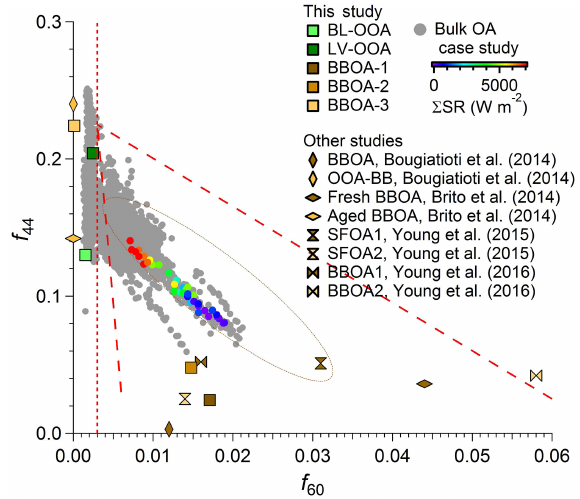
Figure 4. Scatterplot of f 44 vs. f 60 . The grey markers correspond to the measured OA during this study, and the SRCF case study data are colored by cumulative solar radiation ( P SR). In addi- tion, the five OA factors identified in this study are shown as solid squares, and the BBOA factors reported in the literature where mul- tiple BBOA factors were derived are shown with different markers. The dashed red lines denote f 60 = 0 . 003 and the boundaries set for BBOA (Ortega et al., 2013). The brown oval encompasses ARCTAS fire plumes sampled above the North America continent (Cubison et al.,